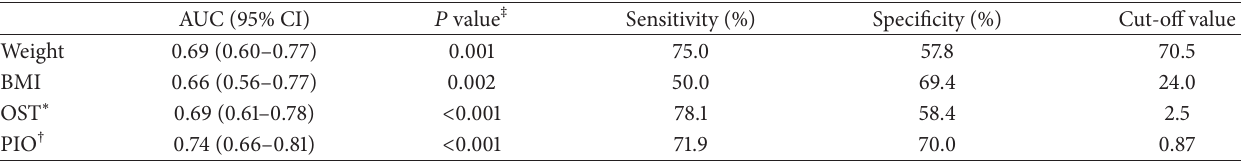
Table 4: Area under the ROC curve, sensitivity, specificity, and the optimal cut-off value (only of predictive index) of variables to predict osteoporosis in men under 70 years of age.